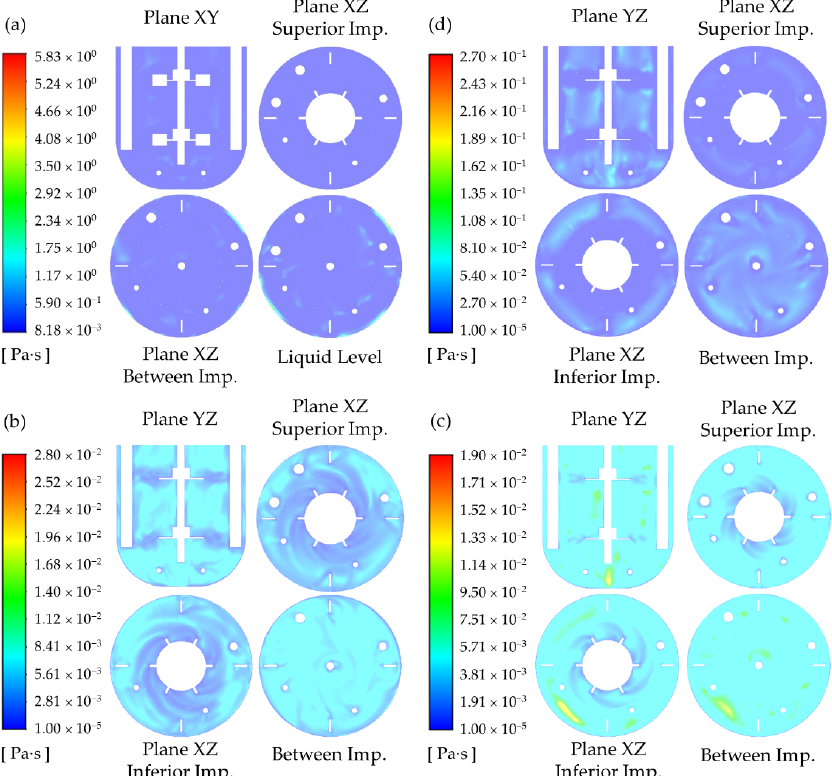
Figure A13. Contours of instantaneous viscosity, computed after 58 impeller turns, for the batch abiotic systems ( a ) XSolC-lam, ( b ) XSolB- SSTkω, ( c ) XSolB- kklω, and ( d ) XSolA- kklω.